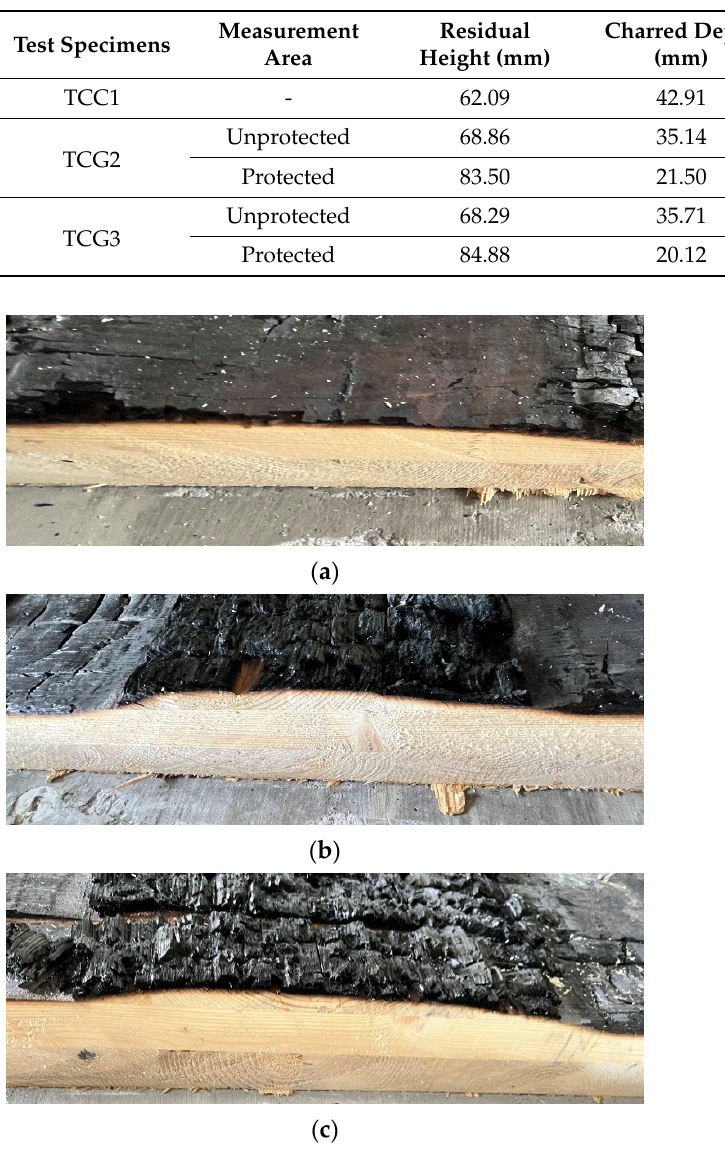
Figure 11. The residual cross sections of the CLT panel after tests: ( a ) TCC1; ( b ) TCG2; and ( c ) TCG3. When the CLT panel was covered with partial Type X gypsum boards, the average charring rates for the unprotected areas of specimens TCG2 and TCG3 were 0.59 mm/min and 0.60 mm/min, respectively. For the protected area, the average charring rates of specimens TCG2 and TCG3 were 0.36 mm/min and 0.34 mm/min, respectively.